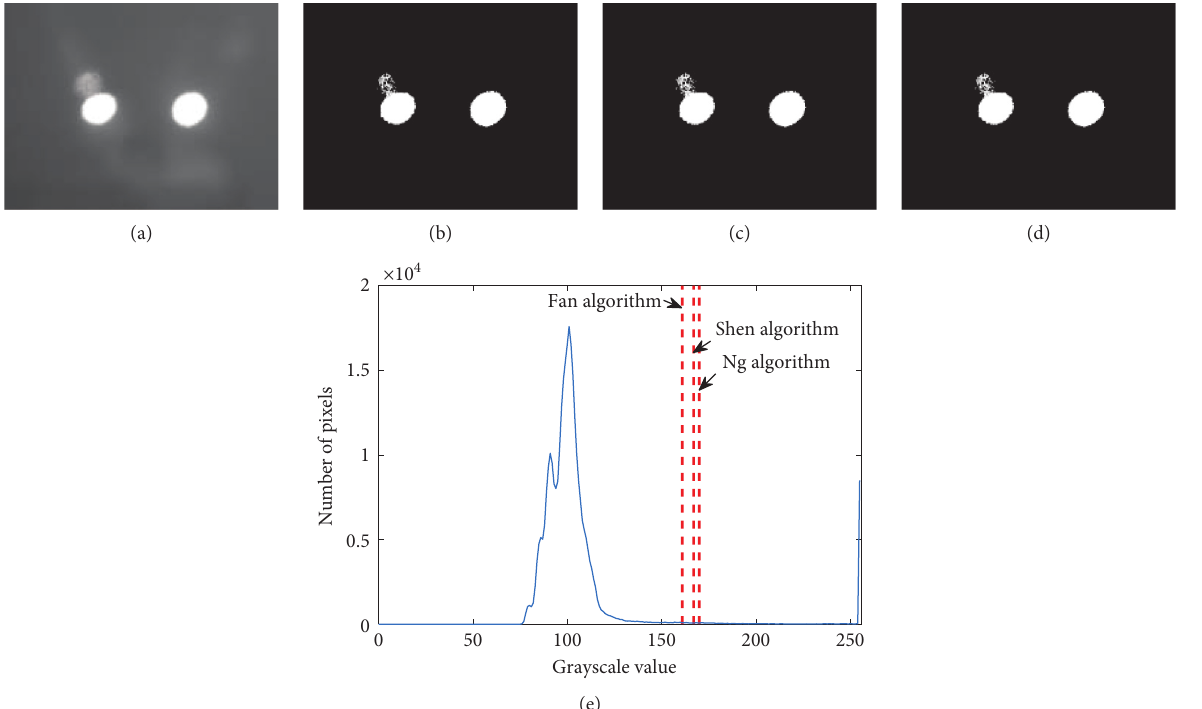
Figure 10: Laser speckle segmentation effect under ghost imaging interference: (a) original image, (b) Ng algorithm, (c) Fan algorithm, (d) Shen algorithm, and (e) histogram and segmentation